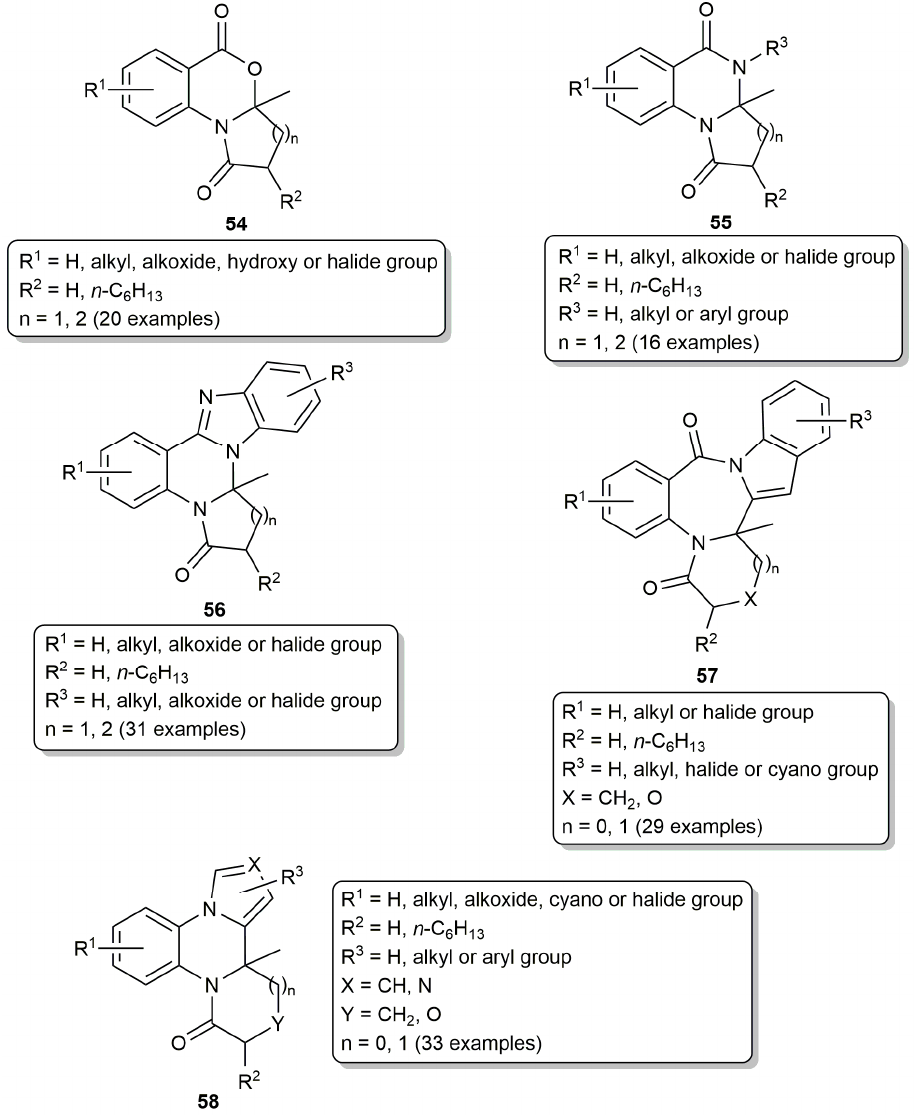
Figure 6. Structures of the fused polycyclic compounds 54–58 .